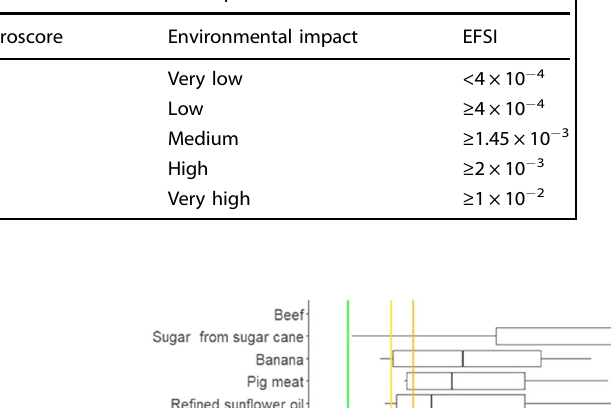
Table 2. Cutoff values and categorization of EFSI index considering the relative environmental impact of the food items.